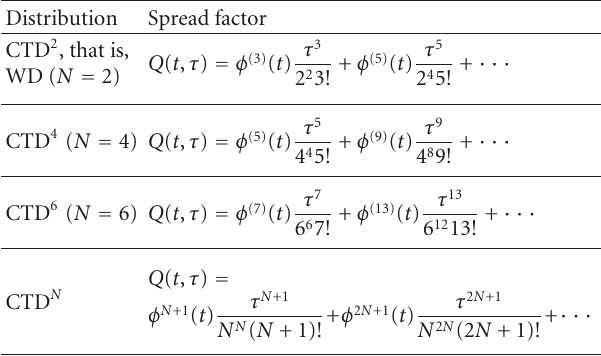
Table 1: Spread factors for some time-frequency